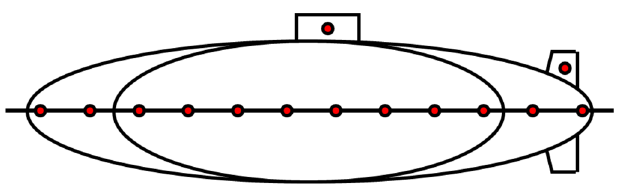
Figure 1. Spheroid-placed highlight modeling.